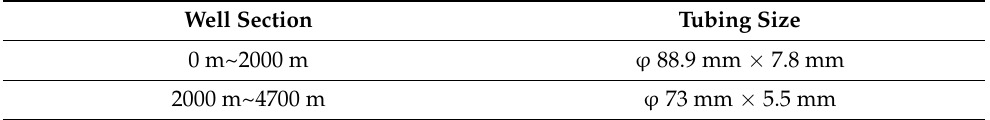
Table 3. Tubing string size of acid injection gas